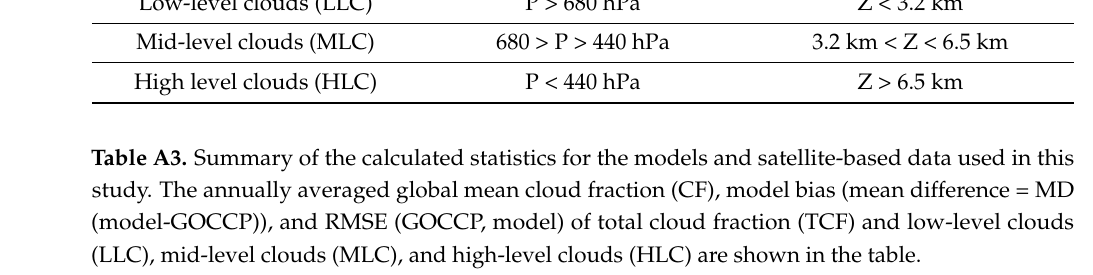
Table A2. The cloud classification scheme based on pressure (P) and height (Z) in CALIPSO-GOCCP data.